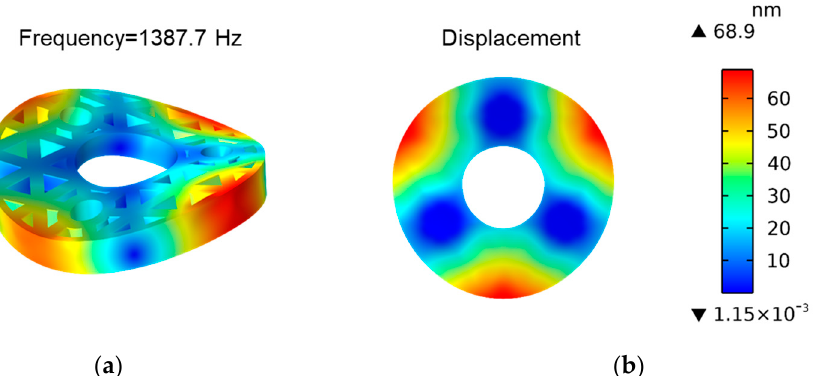
Figure 9. Comparison of the initial mirror and the optimized mirror.